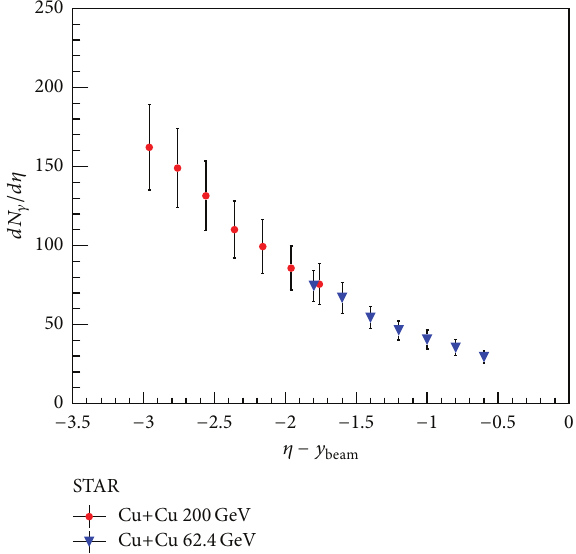
pair for different energies, shown in one of the rest frames of the projectile.